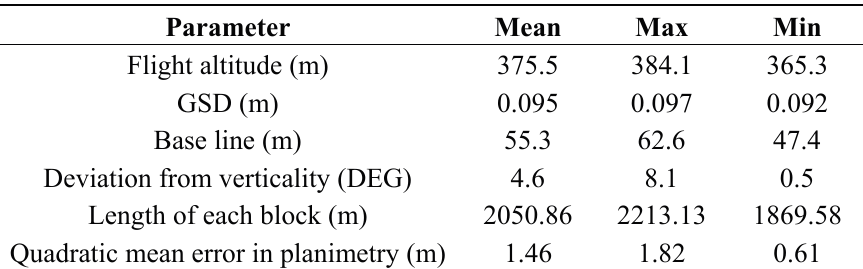
Table 1. Results of the data